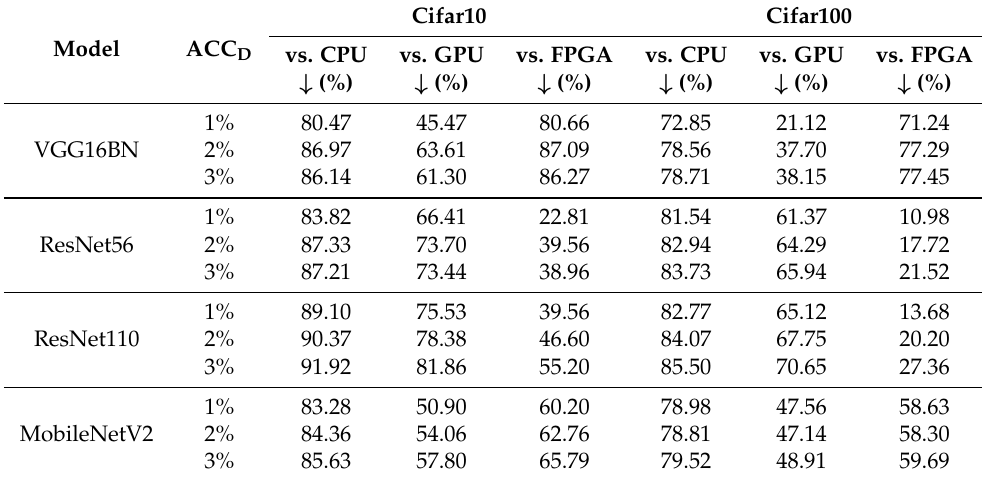
Table 7. Time reduction of the compressed model compared to the base models inference on the CPU, GPU, and